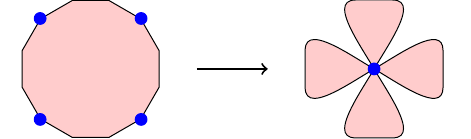
FIG. 4. Merging vertices of a 12-gon. As this procedure effectively removes three independent X checks, we introduce three gauge qubits.